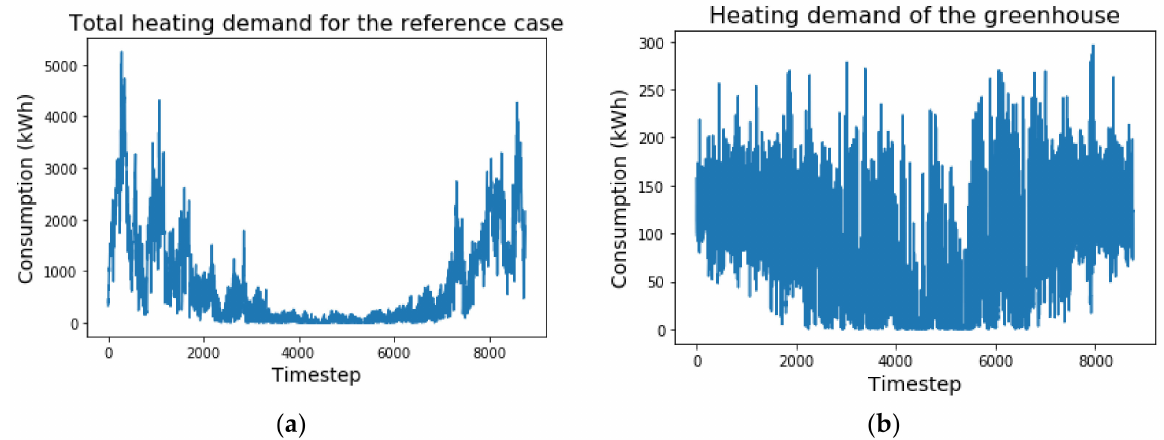
Figure 3. ( a ) Hourly heating demand of the neighborhood. ( b ) Hourly heating demand of the